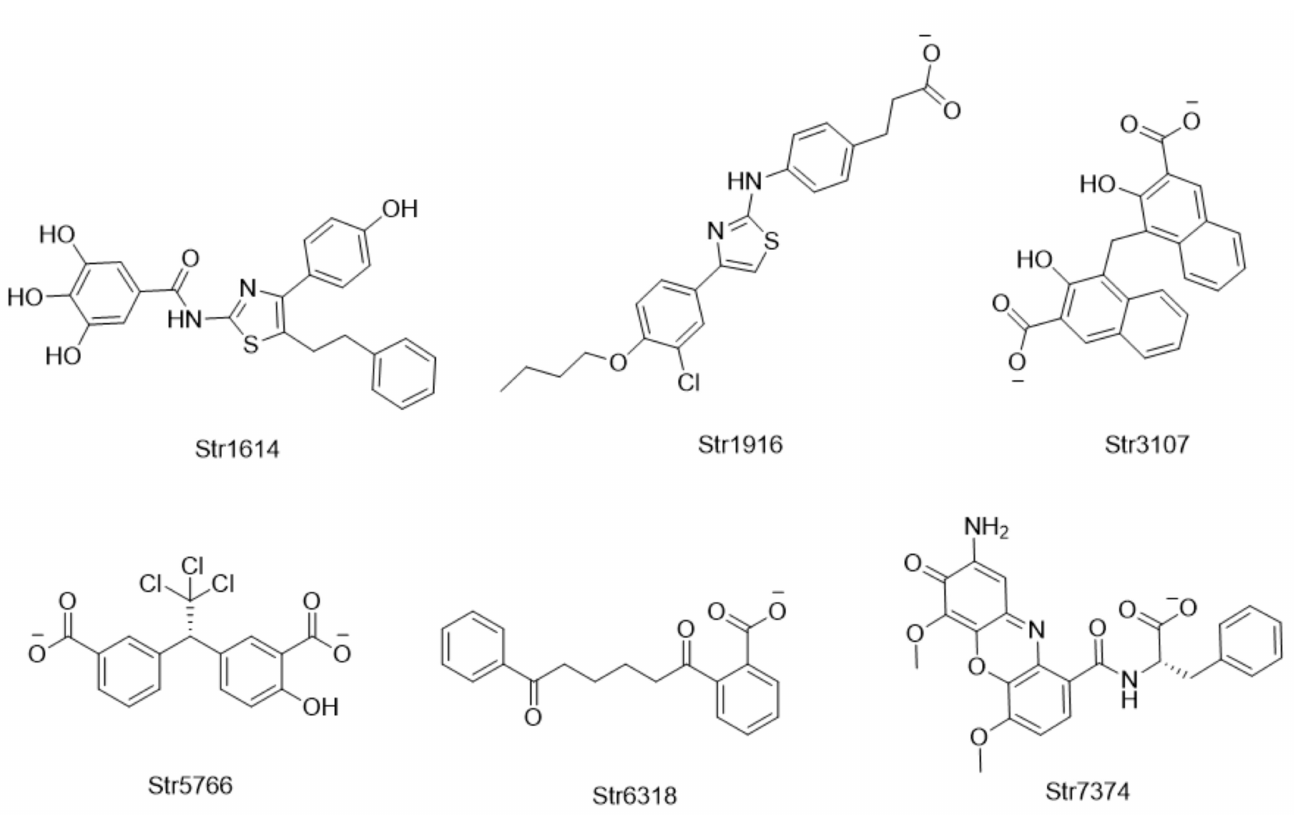
Figure 3. The structures and IDs of the active compounds. Table 1. Structures, docking scores, anti-H1N1 and -H3N2 activities, cytotoxicities and Kd values of the active compounds. Docking Compounds